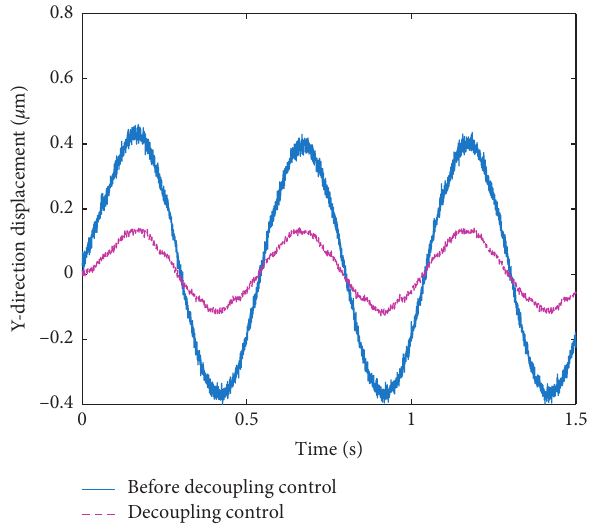
Figure 15: Decoupling control in the Y